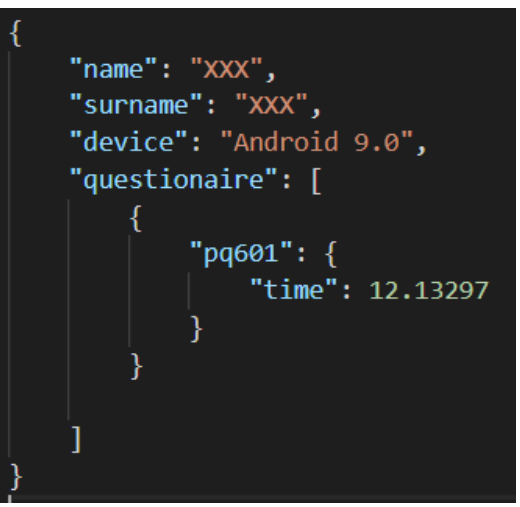
Figure 1. An example of an object containing information about the passing of testing by one par-